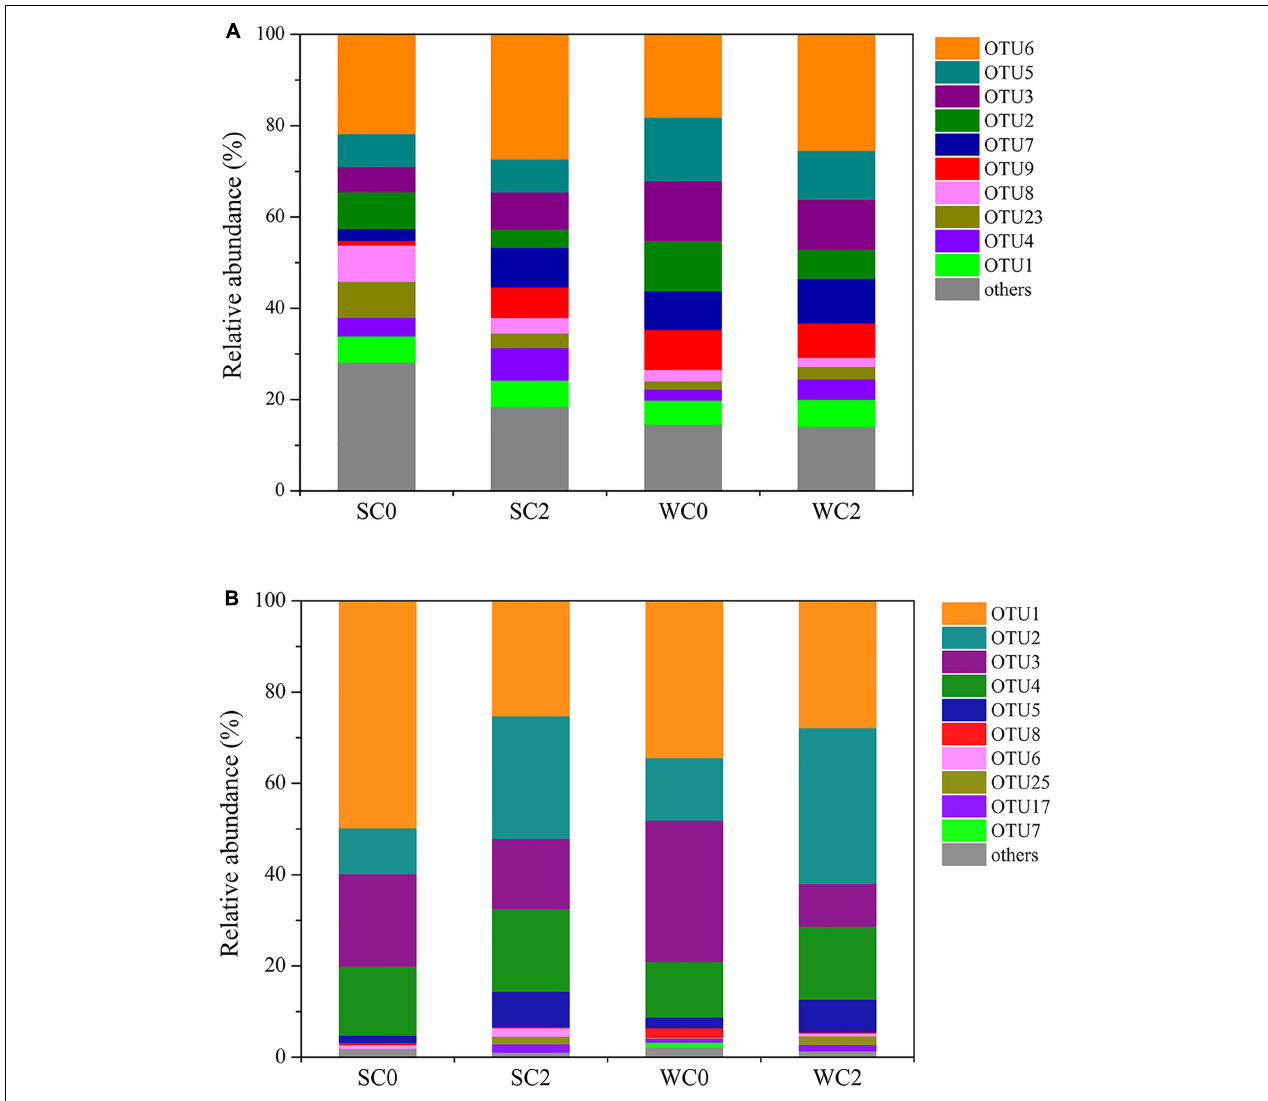
FIGURE 2 | Relative abundance of AOA (A) and AOB (B) OTUs. Only OTUs with relative abundance rankings in the top 10 were